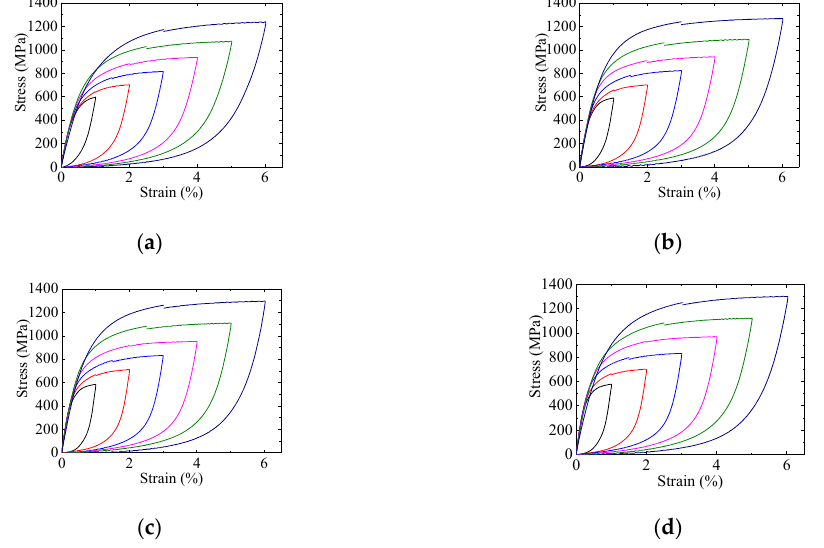
Figure 17. Relative hysteretic curves of S304. ( a ) S ‐ NT; ( b ) S ‐ 900 ‐ 1; ( c ) S ‐ 900 ‐ 2; ( d ) S ‐ 900 ‐ 3.